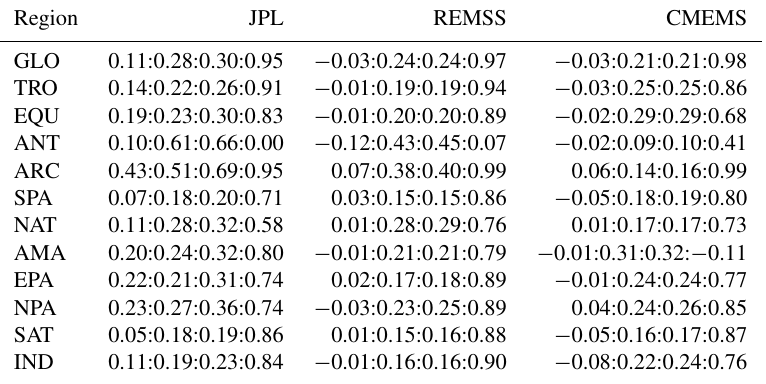
Table 5. Regional statistics of the differences between the SMAP and Argo SSS for the year 2017. For each product and ocean region the mean, standard deviation, root mean square of the difference, and coefficient of correlation r 2 are provided separated by a colon. The table also contains the results for the CMEMS product.